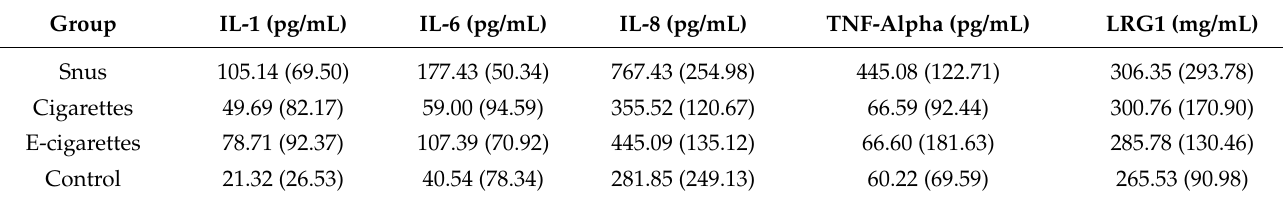
Table 4. Average results of inflammatory biomarkers and LRG1 per